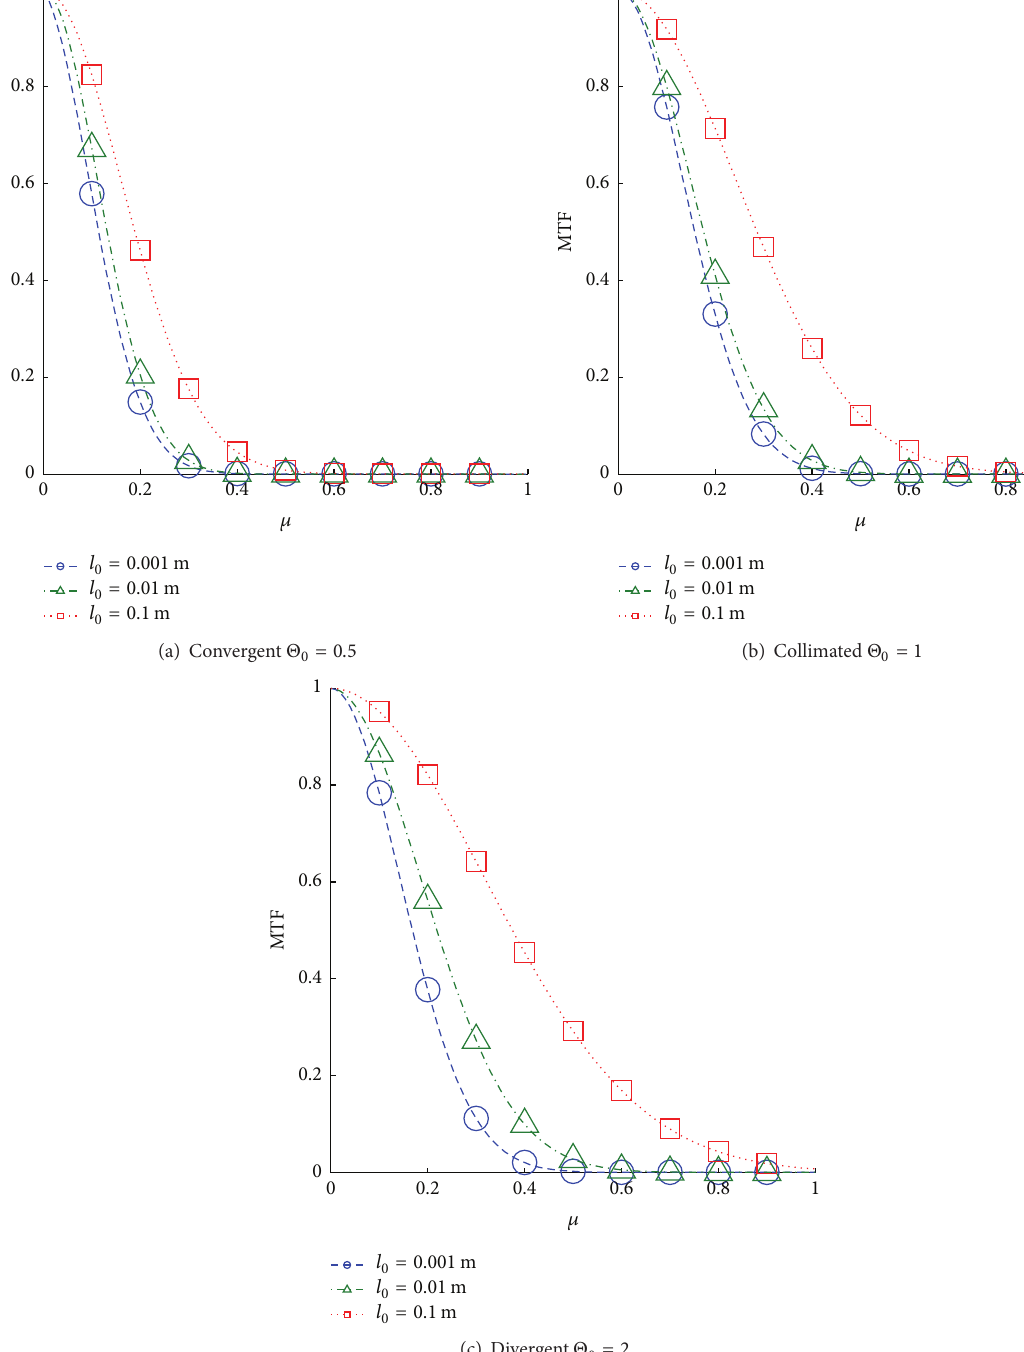
Figure 2: Effects of inner scale on MTF for different types of Gaussian